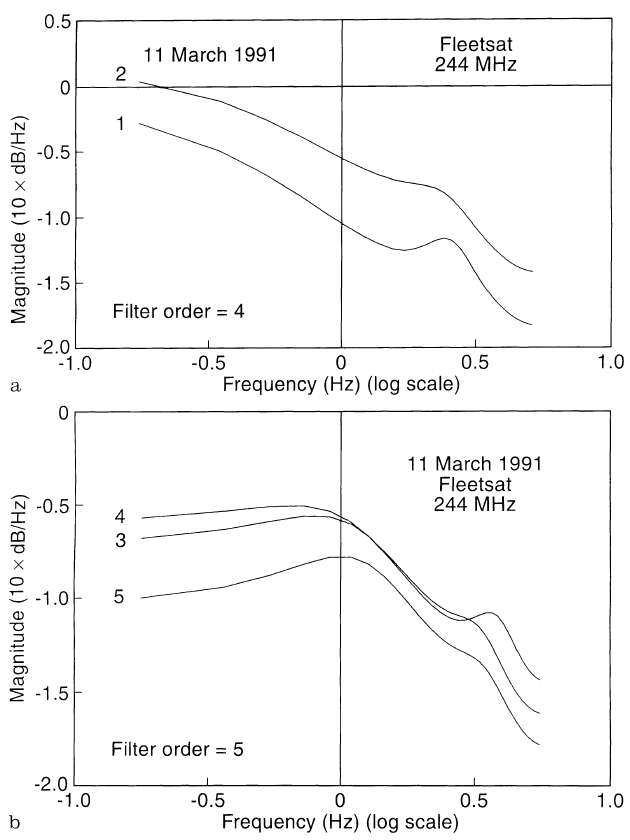
Fig. 8a,b. The power spectra of scintillations represented by higher order AR processes are shown in a and b . These are resolved by 4th and 5th order filters respectively. Note the dual slope nature displayed by all these spectra and the finer variations in their shapes. Again the numbers represent the time sequence of occurrence of these spectra